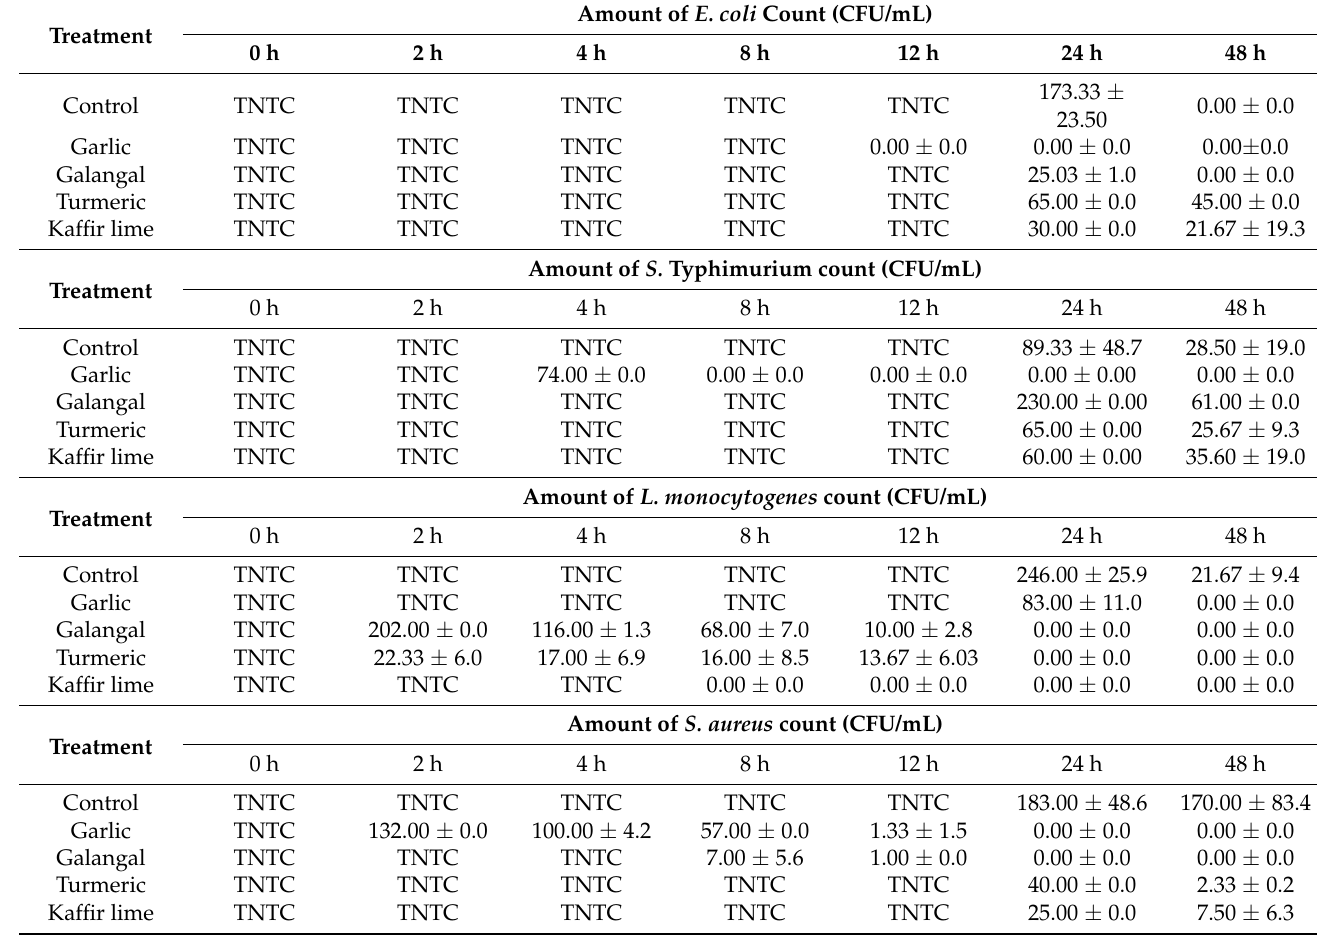
Table 1. Antimicrobial activity of chitosan–NGRS based edible film incorporated with and with- out